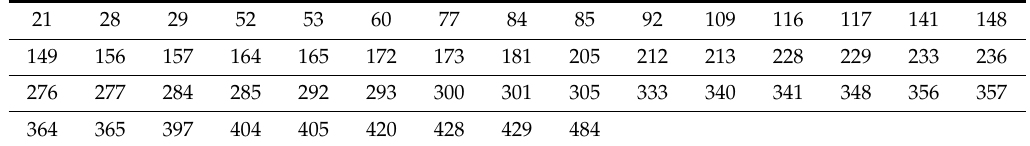
Table 15. x4 and x5 corresponding to block P texture template